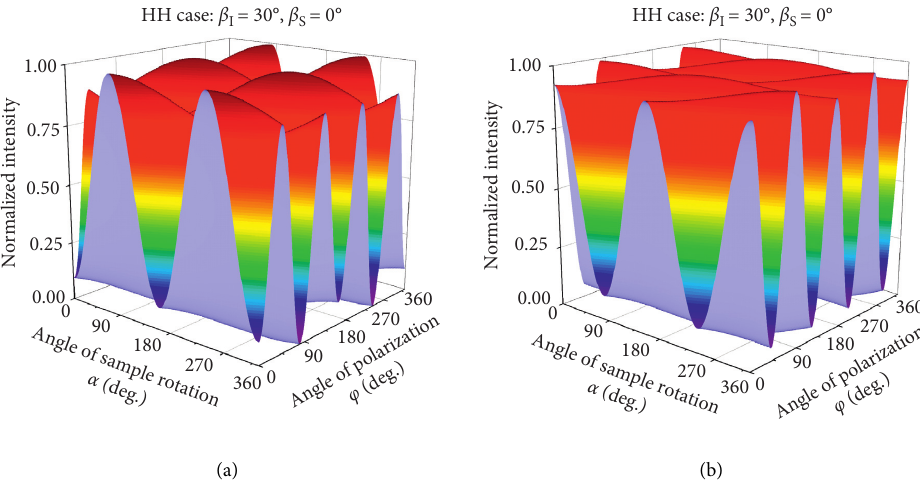
� 30 ° , β � 0 ° ) for different sample rotation angles α and polarization I S